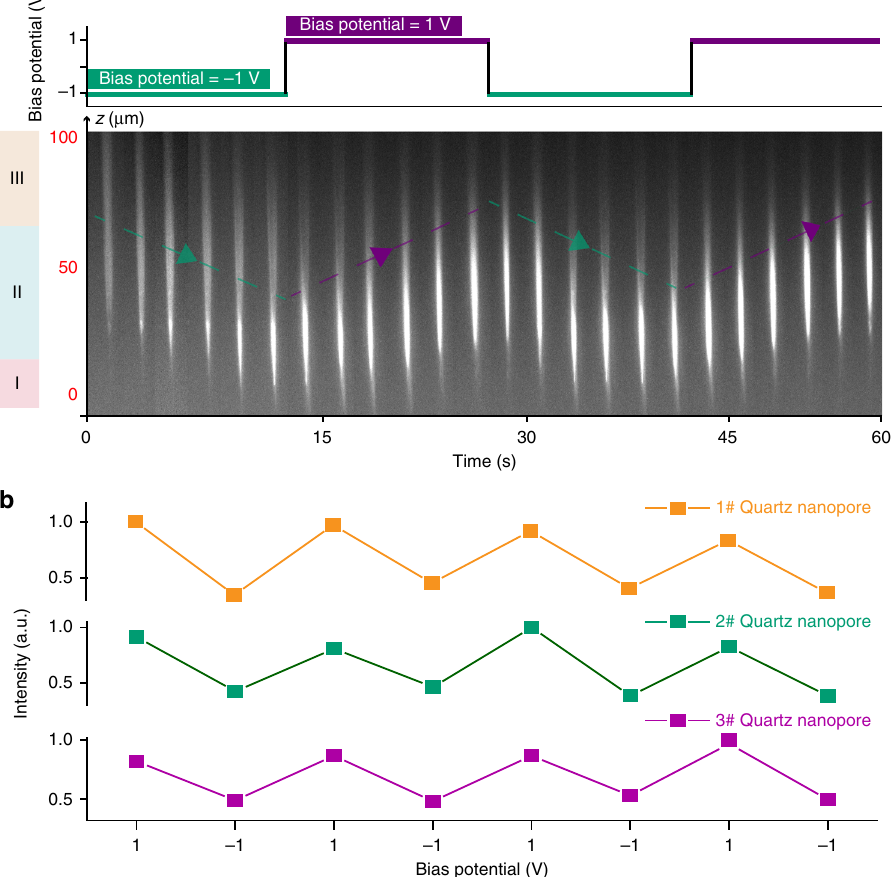
Fig. 2 The reversible manipulating of DMTPS-DCV emission inside a nanopore. a The alternating applied bias potential between 1 V and − 1 V inducing the reversible emission of DMTPS-DCV. The time interval for stepping the potential is 15 s. The nanopore could be divided into three areas alone with the z position as con fi nement I, II, and III, respectively. At the con fi nement II in nanopore, the DMTPS-DCV exhibits the highest emission. b The normalized fl uorescent intensity from three individual quartz nanopores at repeatable potential illustrates the consistent behavior for electrochemically manipulating the DMTPS-DCV. The normalized fl uorescent intensity at each potential is recorded from the pixel at position z = 50 μ